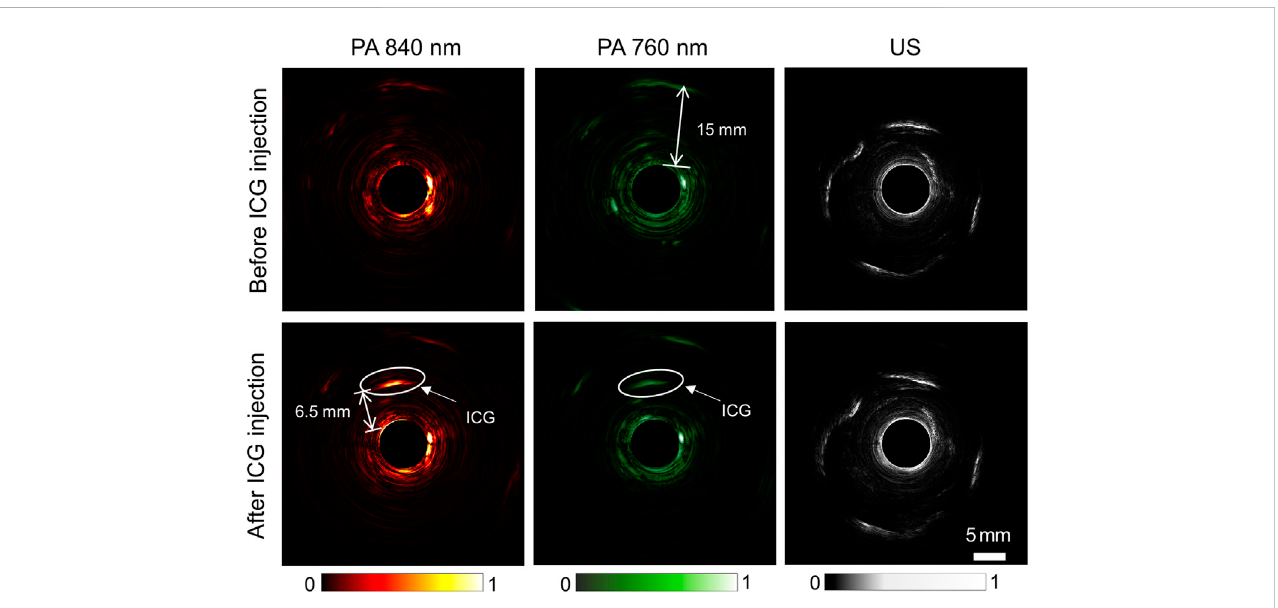
FIGURE 4 Comparison of photoacoustic and ultrasound images of the rabbit rectum before (top row) and after (bottom row) ICG injection. From left to right, the three columns depict photoacoustic imaging results with 840 nm and 760 nm wavelengths and ultrasound imaging results,